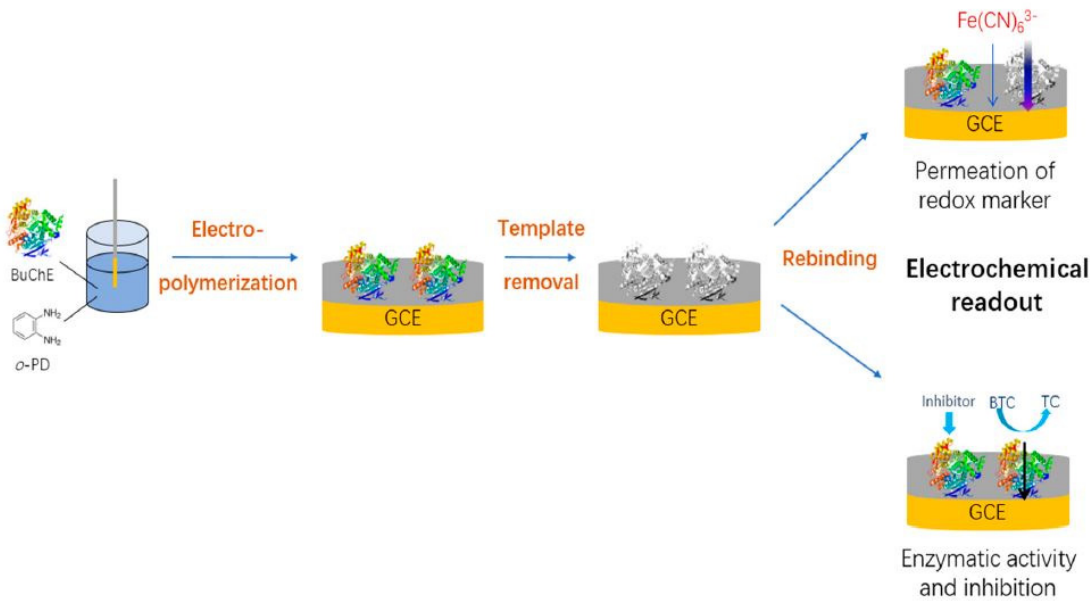
Figure 6. Schematic representation of the preparation and electrochemical characterization of the BuChE ‐ MIP sensor. The MIP layer was formed by electropolymerization of o ‐ PD in the presence of BuChE on the surface of glassy carbon electrodes, followed by incubation in 100 mM NaOH to remove the template. All steps of MIP synthesis and re ‐ binding of BuChE were evaluated by measurement of ferricyanide by CV and amperometric measurement at 0.4 V of thiocholine formed during BuChE ‐ catalyzed conversion of butyrylthiocholine iodide (BTC).